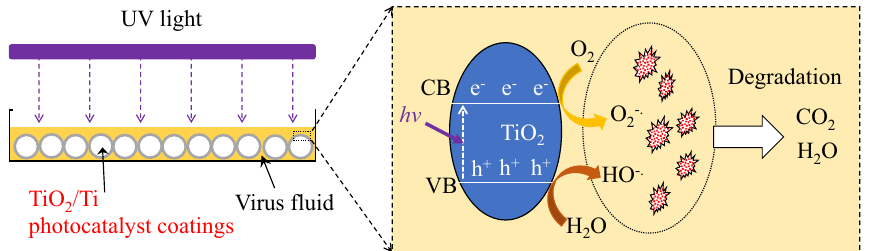
Figure 6. Proposed mechanisms of viral inactivation induced by TiO 2 /Ti photocatalyst